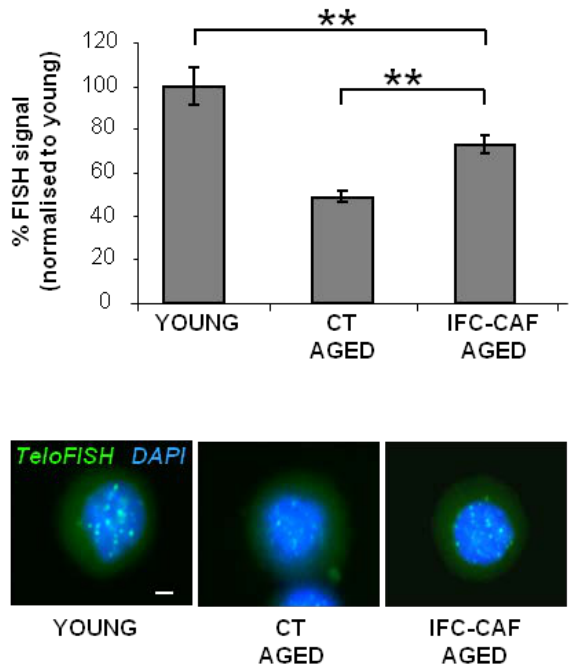
Figure 6. IFC-CAF ® protects aging stem cells from telomeric shortening. TeloFISH quantitative imaging of either ´ young ´ keratinocytes, keratinocytes aged for 24 days, or aged keratinocytes supplemented with 0.9 mg/mL (representative micrographs in bottom panels; scale bar: 2 µ m), representative of two independent experiments (bar histogram). Data are represented as percent of signal relative to young keratinocytes. Statistical significance was assessed by Student ´ s t test (**: p < 0.01).